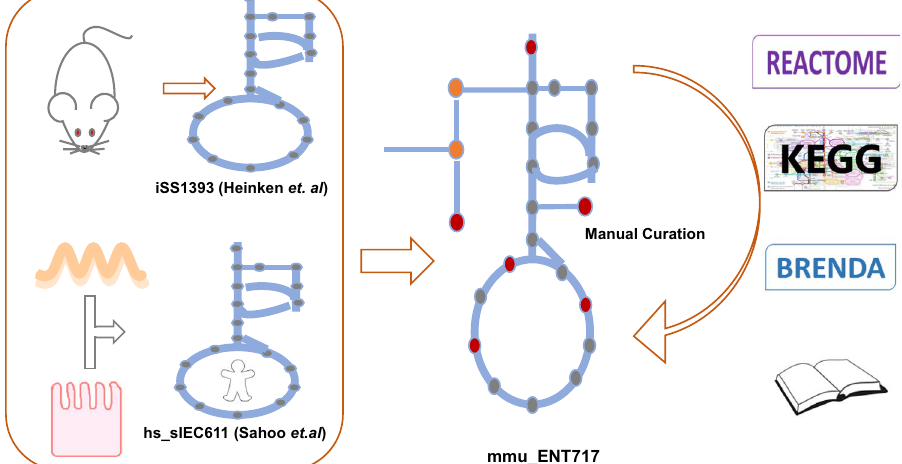
Figure 1. Model construction. Schematic overview of the construction process of a metabolic model of murine enterocytes. An existing genome scale murine metabolic model and a model of human small intestinal epithelial cells were combined; the resulting draft underwent extensive manual curation to arrive to mmu_ENT717 . Key features of this model are summarized in Table 1.